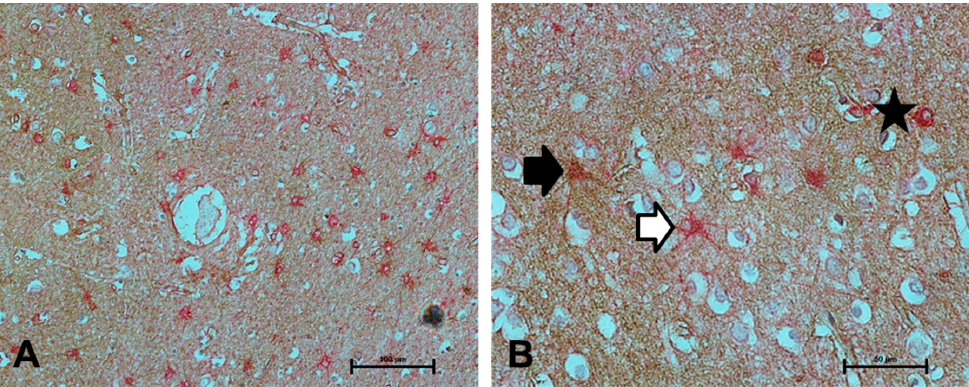
Figure 2. Colocalisation of NDRG2 with GFAP. ( A – B ) Colocalisation of NDRG2 (brown) with GFAP (red) was frequently observed (as indicated by the star), however both NDRG2 +/ GFAP- (black arrow) and NDRG2- / GFAP + astrocytes (white arrow) were detected in the ageing temporal cortex. Scale bar represents 100 μ m in A and 50 μ m in B.